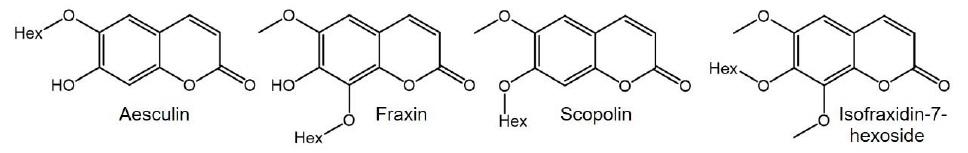
Figure 4. Structures of coumarin hexosides detected in M. recutita roots.